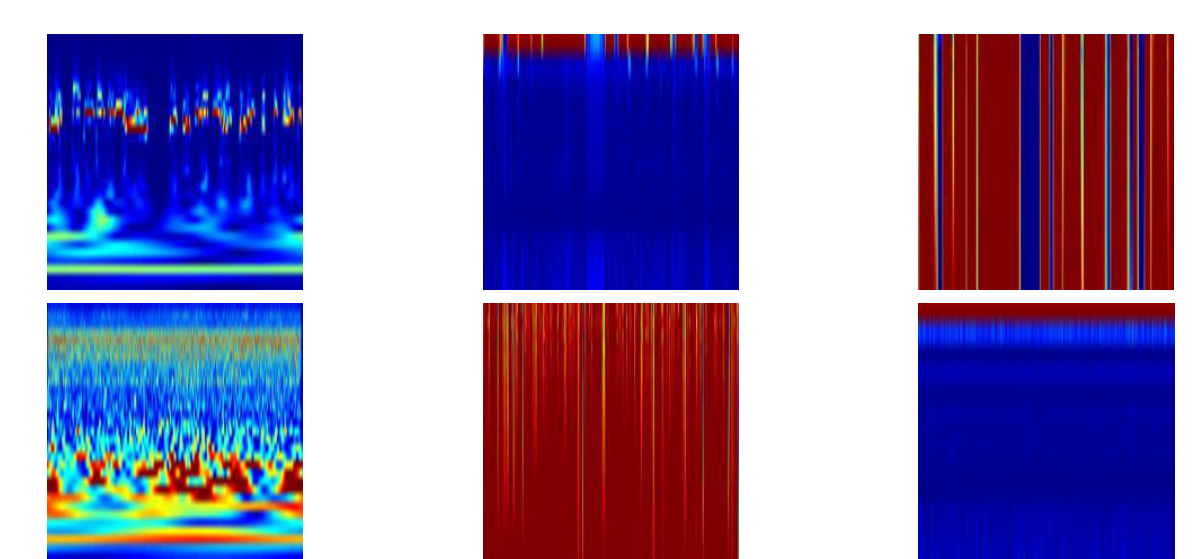
Figure 4. Feature representation samples using the ‘Speech’ ( top ) and ‘Kitchen’ ( bottom ) classes: Left to Right: CWT Scalograms, Log-Mel, and MFCC.